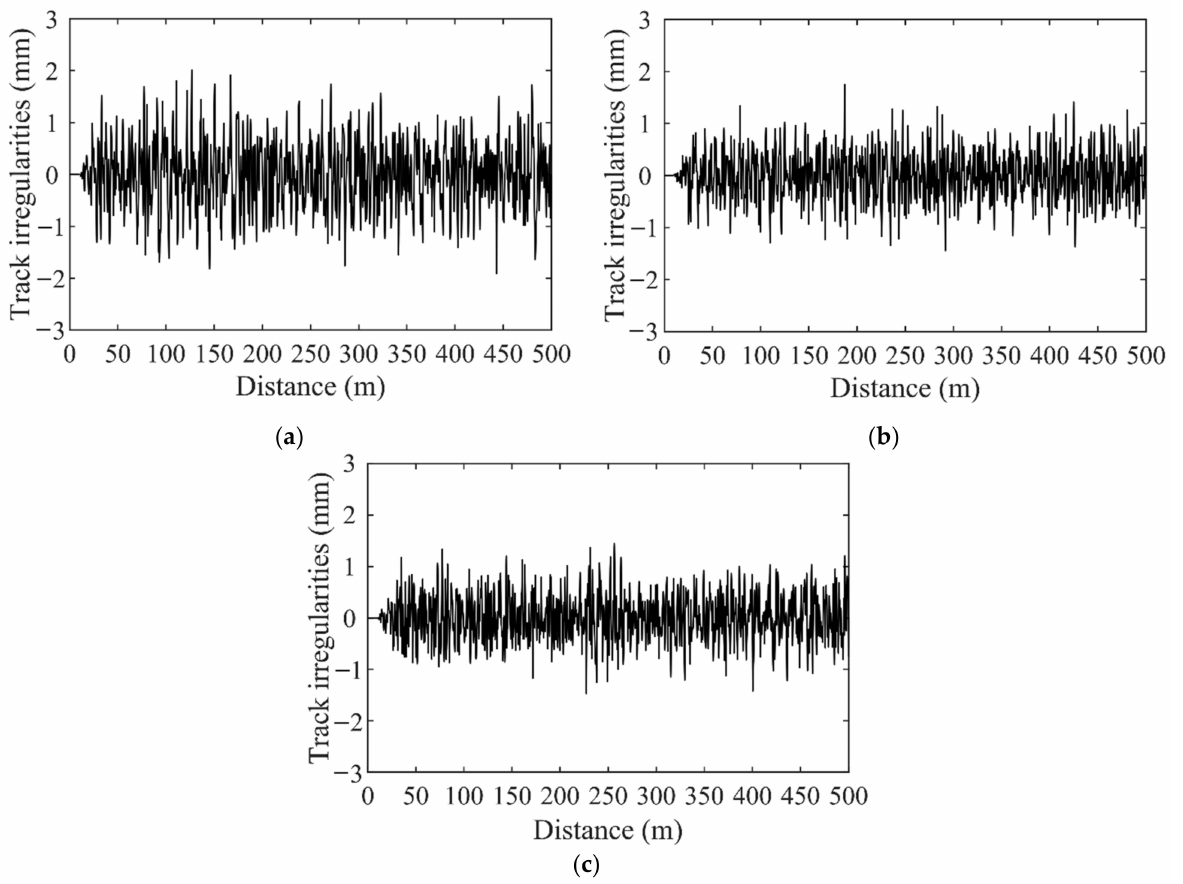
Figure 7. Track beam irregularities: ( a ) Driving wheels; ( b ) Guiding wheels; ( c ) Stabilizing wheels.